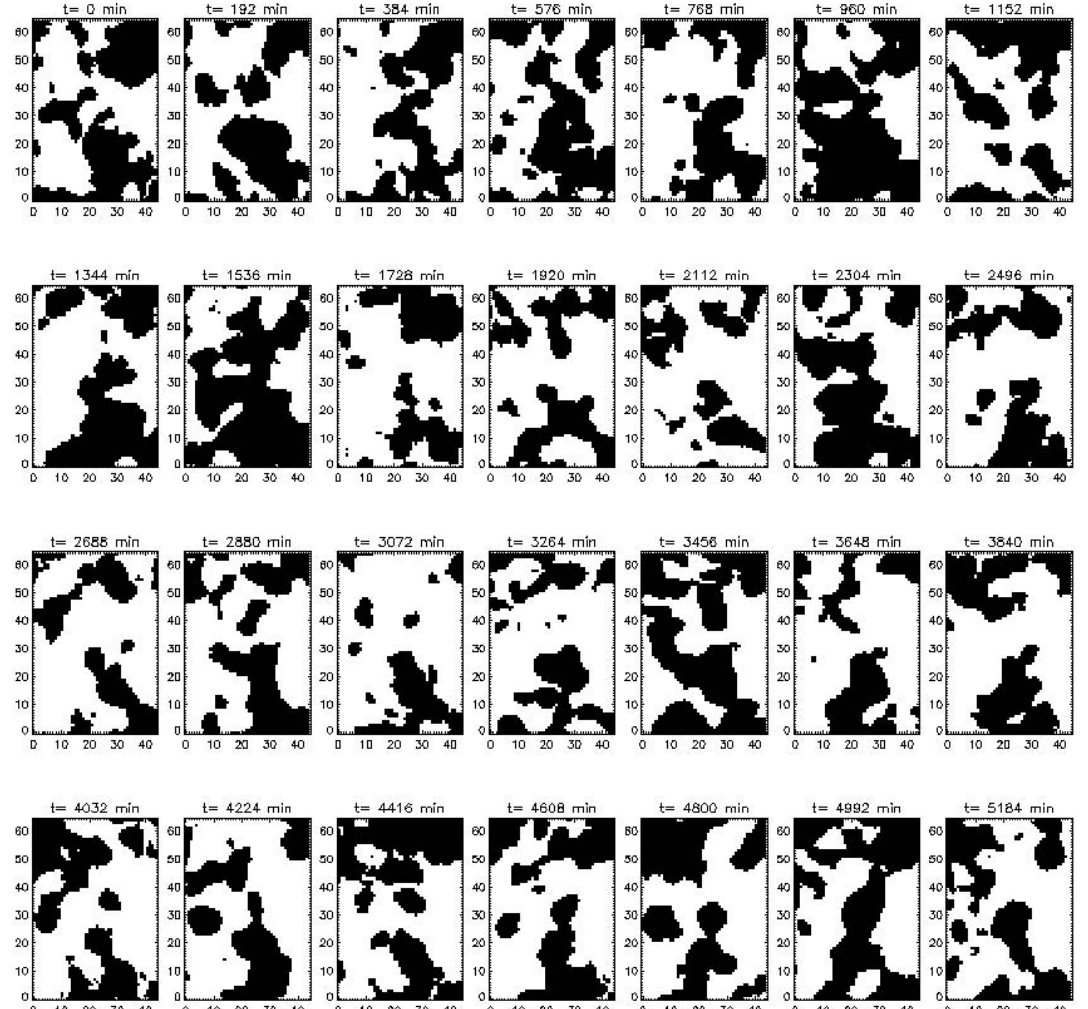
Figure 6. Time evolution of the regions where the velocity is above the threshold value of v = 23 . 6ms − 1 , shown in black, for a period of 3.6d starting on 31 December 2000 at 01:34:43UT. The x and y axes show the spatial coordinates in pixel values, where each pixel corresponds approximately to